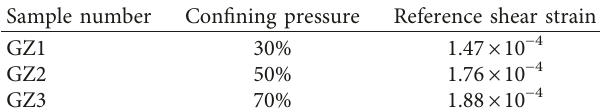
Figure 11: Fitted curves of G / G pressures. Table 5: Reference shear strains under different confining pressures.